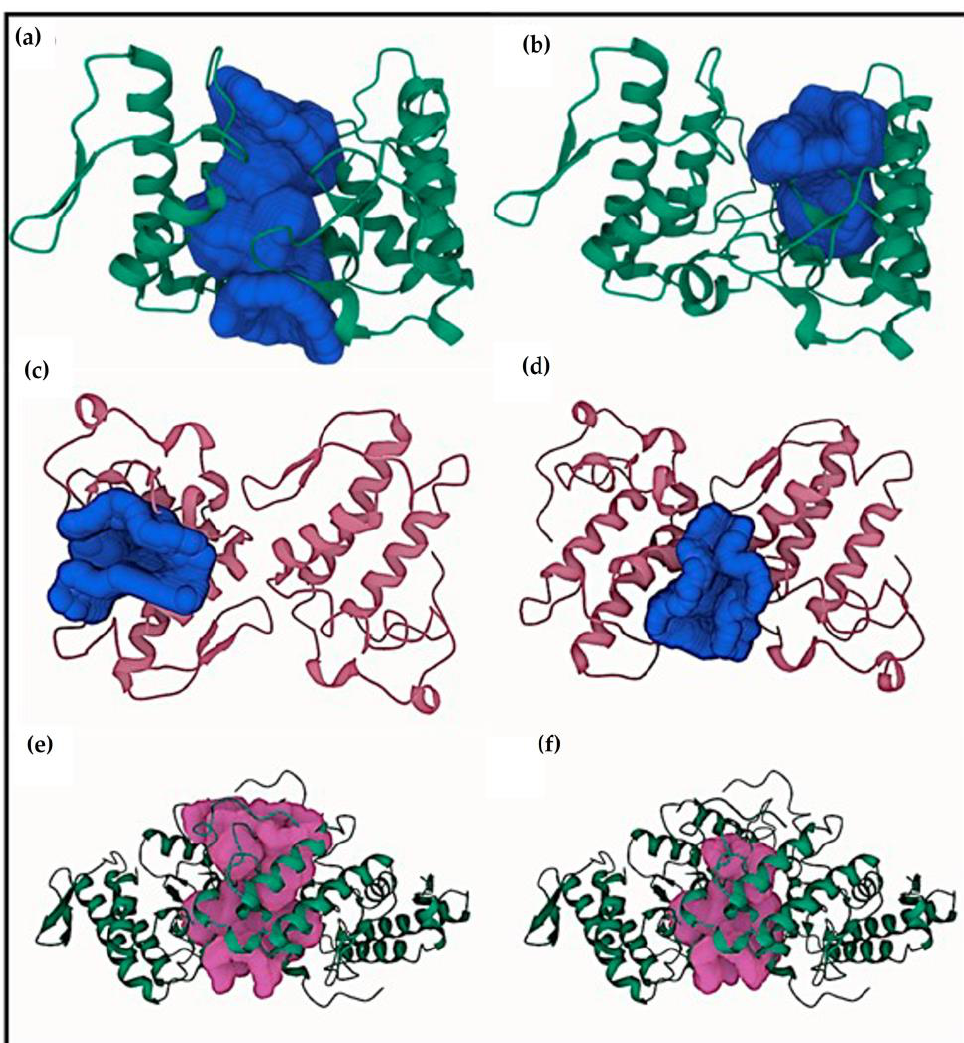
Figure 2. Two best cavities of each protein according to the highest druggability values. (a) First cavity observed in BthTX-I between chain A and B and the second region exhibited in the chain A hydrophobic channel (b) . In (c) , the highest value of druggability shows cavity in the chain B active site, and the second, in the interface between chain A and B (d) . In (e), CdtsPLA2 reveal a huge area in the interface, and a small one, also in the interface (f).